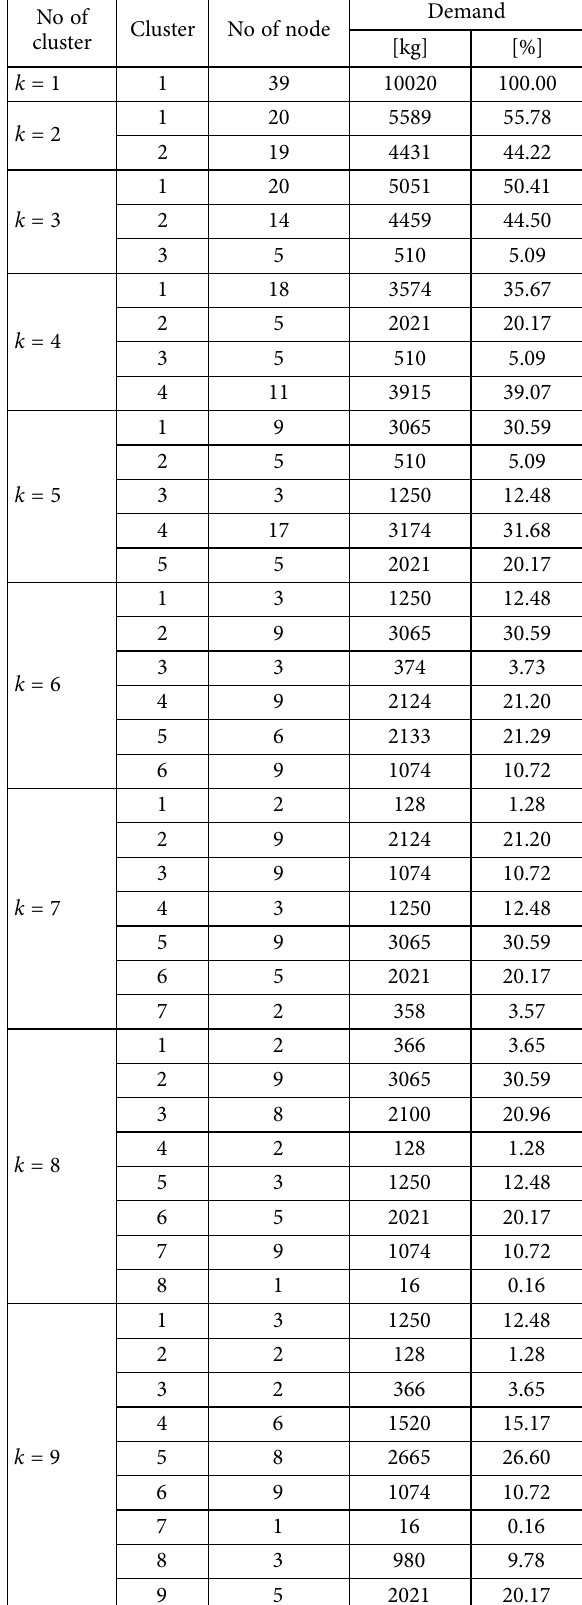
Table 3. Classical k -means clustering results